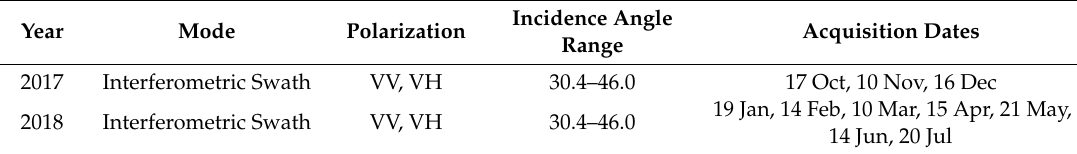
Table 3. Sentinel-1 SLC data used in Dickinson, North Dakota study region.